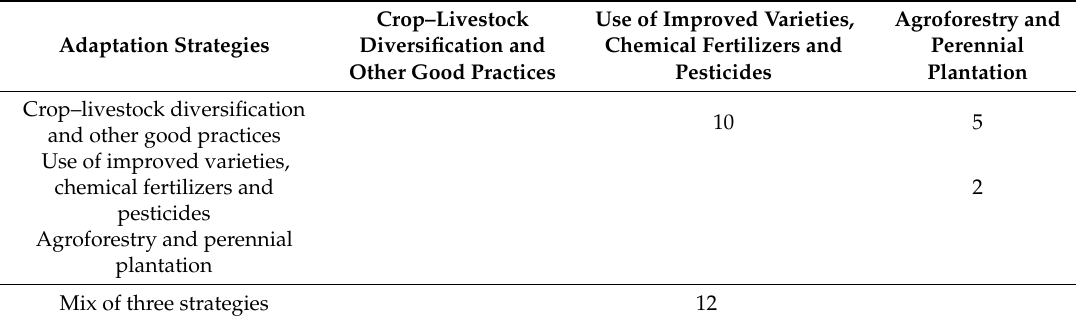
Table 3. Combination of agronomic